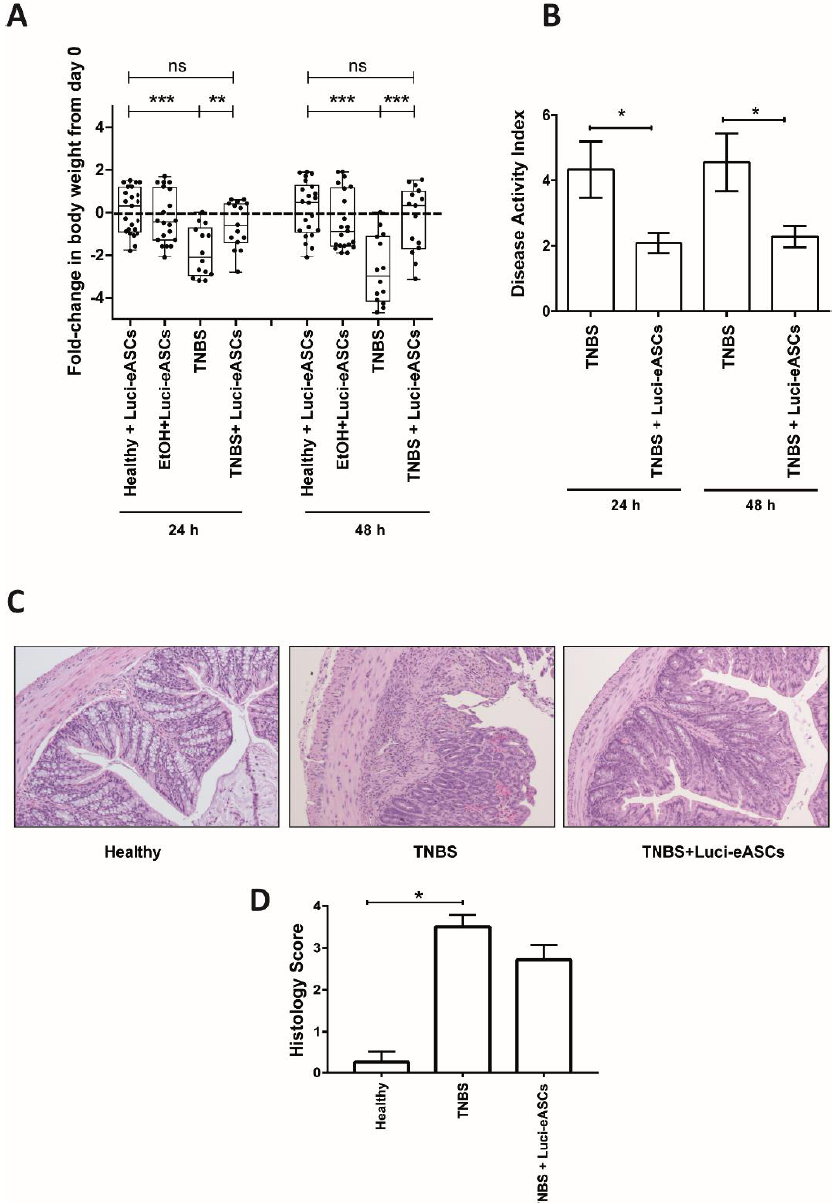
Figure 3. Fold-change in body weights, disease activity index and histological analysis in healthy and TNBS-colitic mice following intraperitoneal (IP) administration of Luci-eASCs. ( A ) Fold-change in body weight at 24 h and 48 h respect to day 0. Healthy + Luci-eASCs, n = 22; EtOH + Luci-eASCs, n = 20; TNBS, n = 14 and TNBS + Luci-eASCs, n = 15. Data are presented by dots and box-plots that represent the interquartile range (p75, upper edge; p25, lower edge; p50, midline; p95, line above the box, and p5, line below the box) of the fold-change in body weight at 24 and 48 h with respect to day 0. ( B ) Disease activity index at 24 h and 48 h of TNBS ( n = 9) and TNBS + Luci-eASCs ( n = 23). Data are presented by mean and standard error of the mean of disease activity index at 24 h and 48 h. ( C ) Representative images of colon tissue (10× magnification) at 48 h of healthy +Luci-eASCs, TNBS and TNBS + Luci-eASCs mice. ( D ) Histology score of healthy + Luci-eASCs ( n = 4), TNBS ( n = 4) and TNBS + Luci-eASCs ( n = 7). Data are presented by mean and standard error of the mean of histology score at 48 h. Significance was analyzed by the Mann-Whitney U test and represented by * p < 0.05, ** p < 0.01, *** p < 0.001 and ns, not significant. Results correspond to four independent experiments.